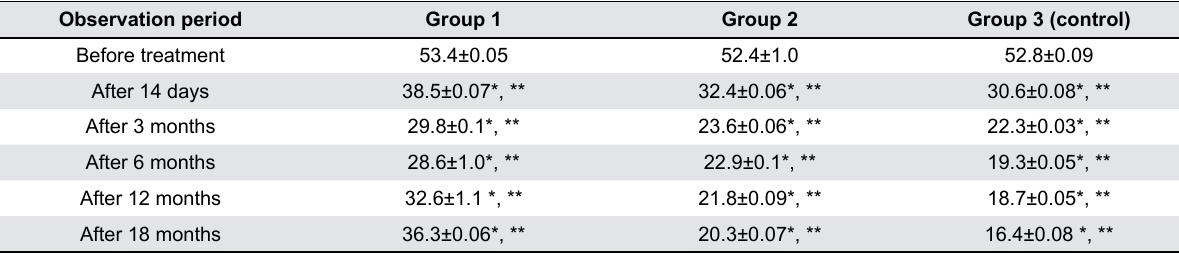
Note: *statistically significant difference as compared to the pre-treatment value, p<0.05; **statistically significant intergroup difference, p<0.05. Table 4- The dynamics of the papillary-marginal-alveolar index (pma)